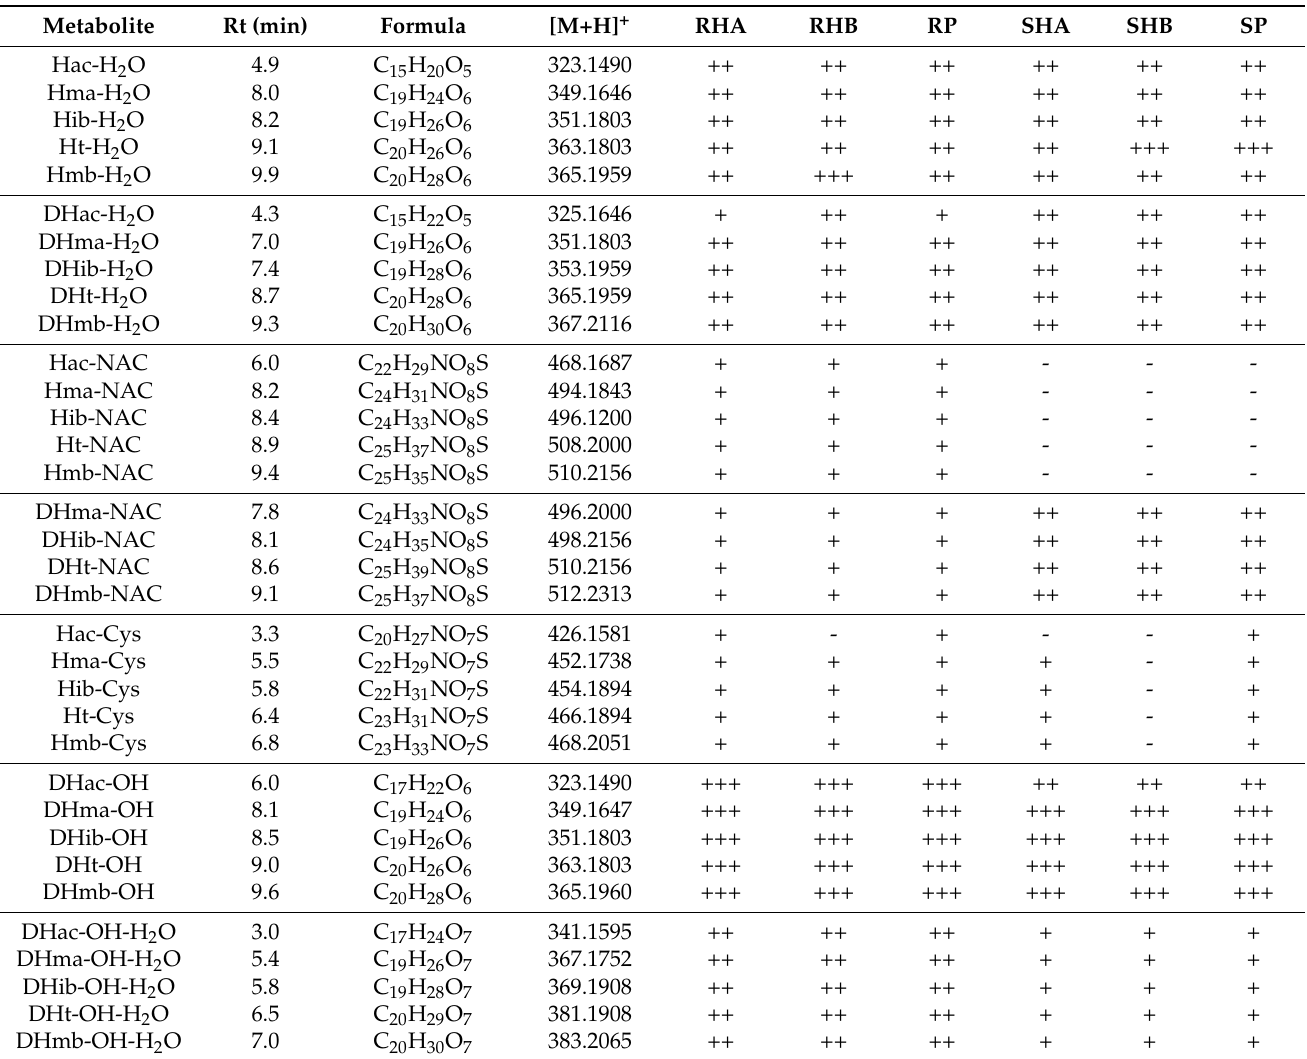
Table 3. Metabolites in receptor fluids after 48 h (R), and skin extracts (S) of human skin A (HA), human skin B (HB) and pig skin (P). Differentiation in low (+, I < 1000), medium (++, 1000 < I < 10,000) and high (+++, I > 10,000) intensity or not detected (-) in base peak